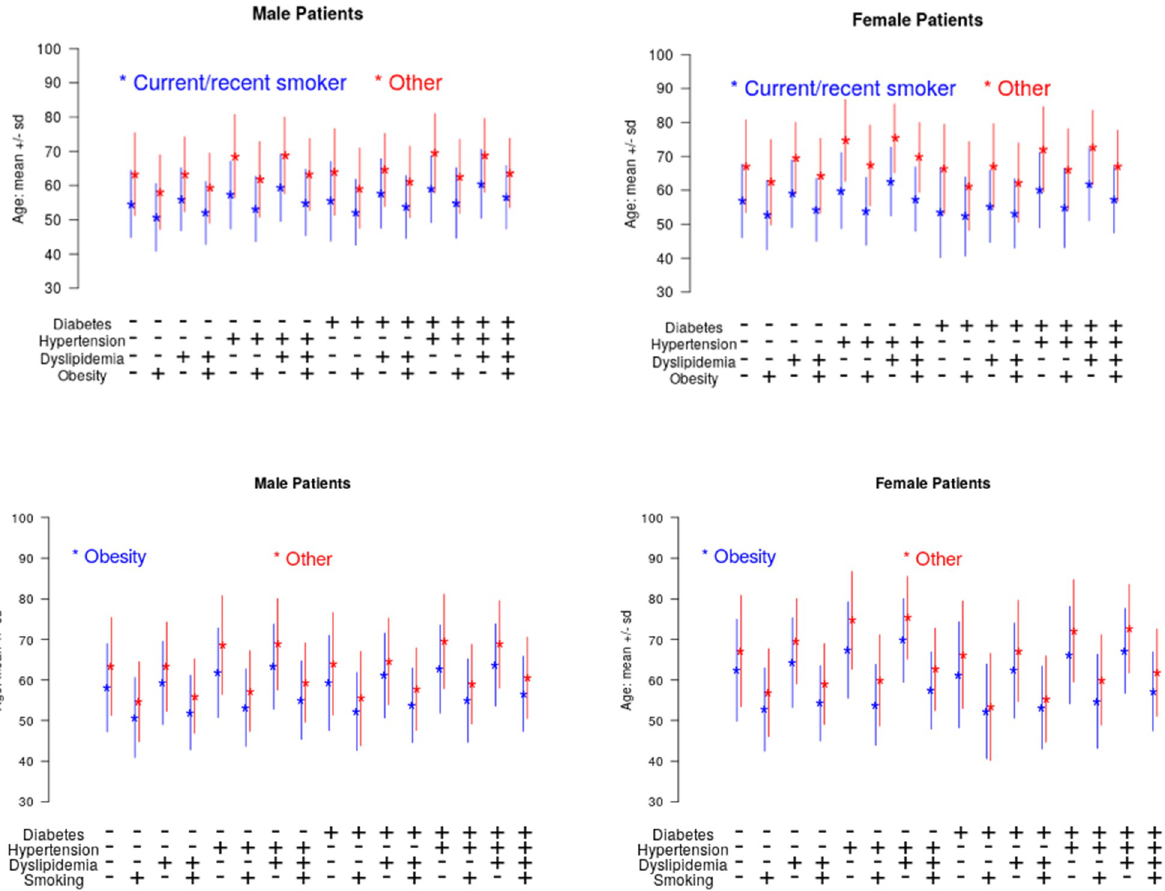
Fig 2. Age at the time of presentation by the presence and absence of a smoking and obesity across a background of other risk factors. Panel A depicts male patients smoking versus non-smoking. Panel B depicts female patients smoking versus non-smoking. Panel C depicts male patients who are obese vs non-obese. Panel D depicts female patients who are obese vs non-obese. Blue bars represent patients with the risk factor and red bars represent patients without the risk factor. Risk factor combinations are depicted along the x axis.